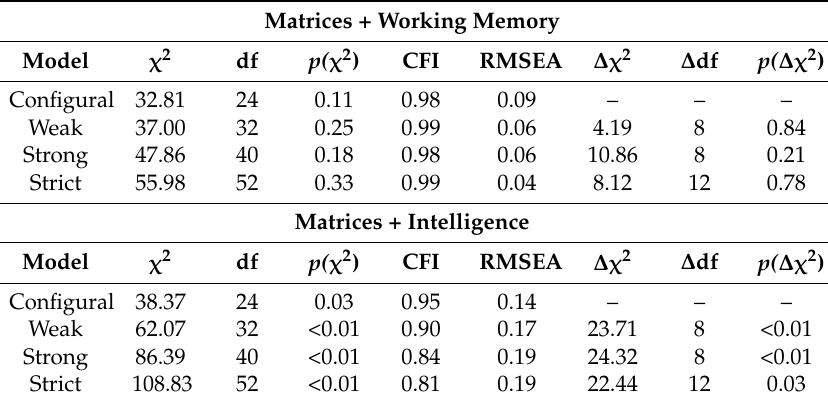
Table 3. Tests of measurement